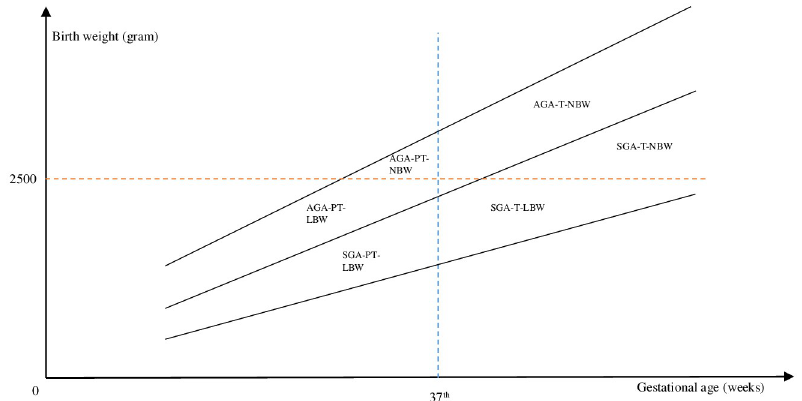
Fig 1. The relationship between preterm birth, LBW and SGA. The figure shows the relationship between the birth outcomes preterm, LBW and SGA. NBW = normal birth weight; LBW = low birth weight; T = term-born; PT = preterm-born; SGA = small for gestational age; AGA = appropriate for gestational age [44].